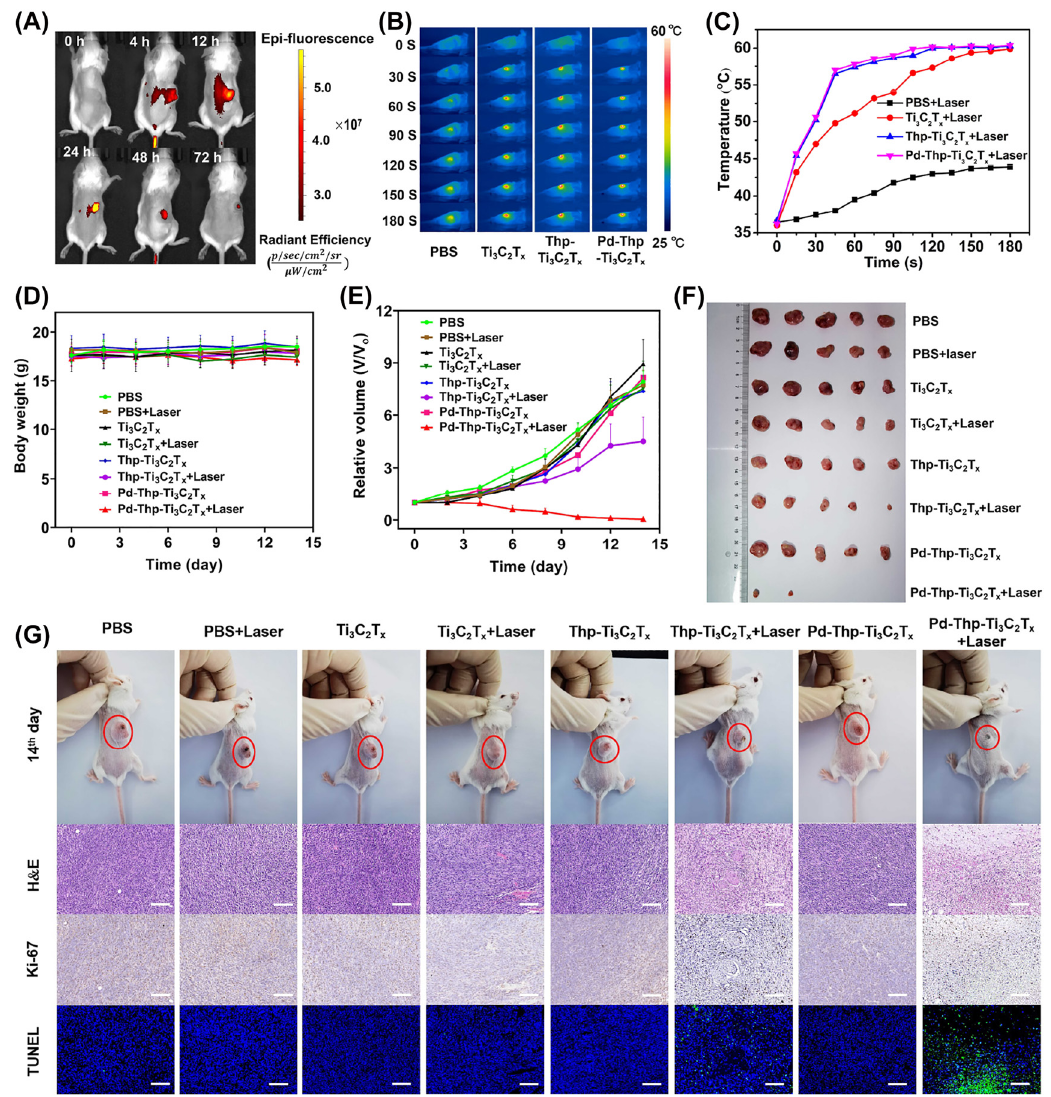
C T for anticancer therapy. (A) In vivo fluorescence imaging of 3 2 x C T -Cy7 at different time. (B) IR photothermal images of CT26-tumor-bearing mice in 3 2 x + Laser, Thp-Ti + Laser and Pd-Thp-Ti + Laser, and (C) corresponding C T C T C T 3 2 3 2 3 2 x x x